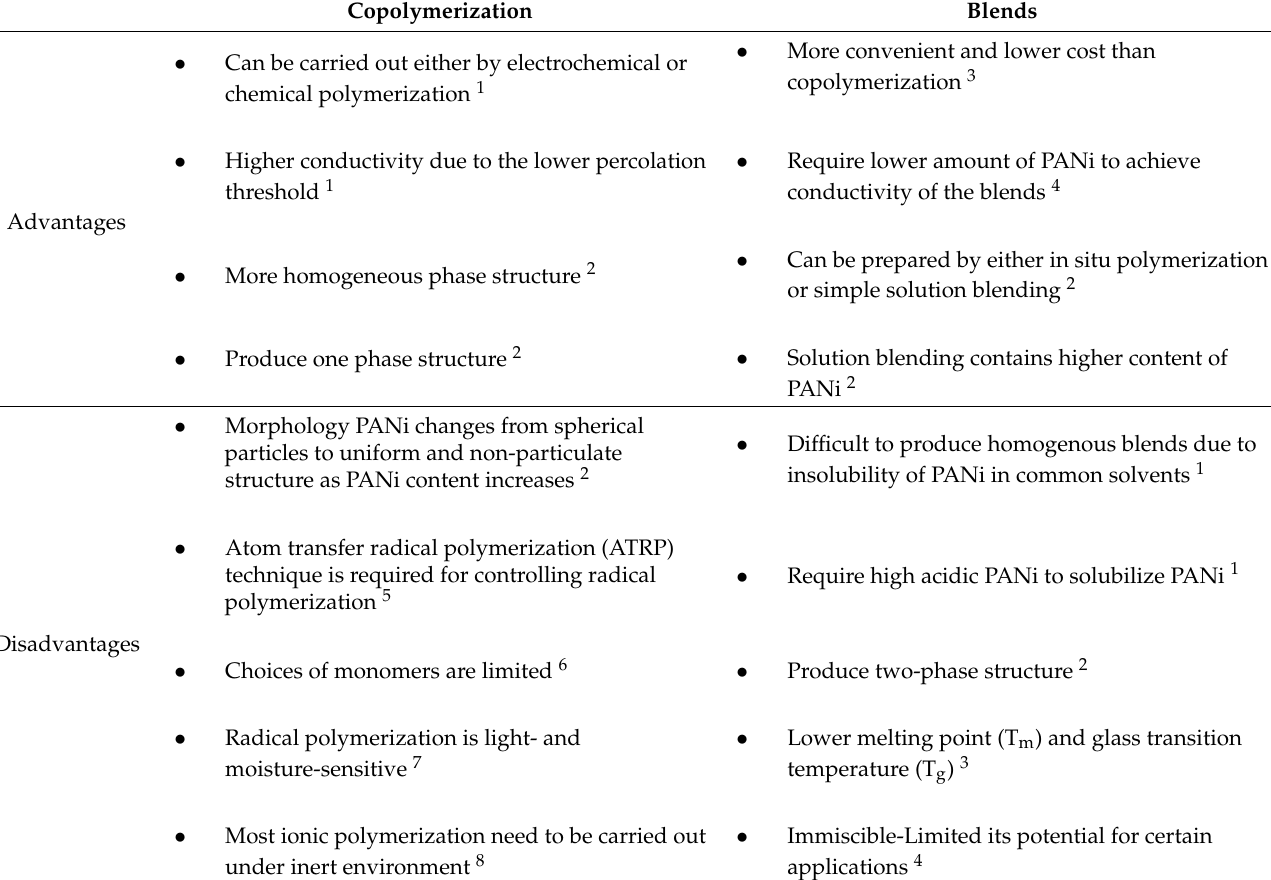
Table 7. Advantages and disadvantages of copolymerization and blending